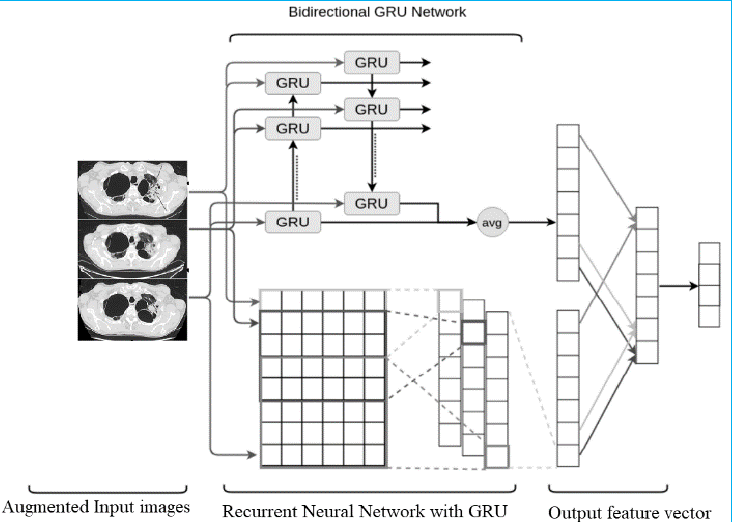
Figure 7. Bidirectional GRU with RNN for feature extraction.